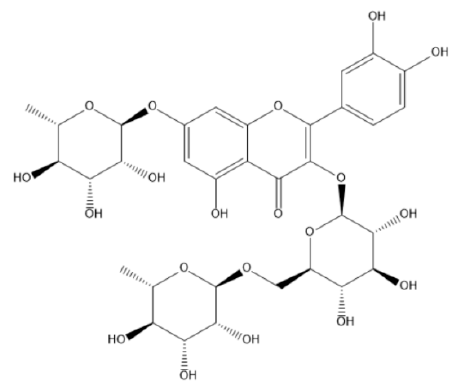
Figure 2. Chemical structure of quercetin-3-rutinoside-7-rhamnoside.